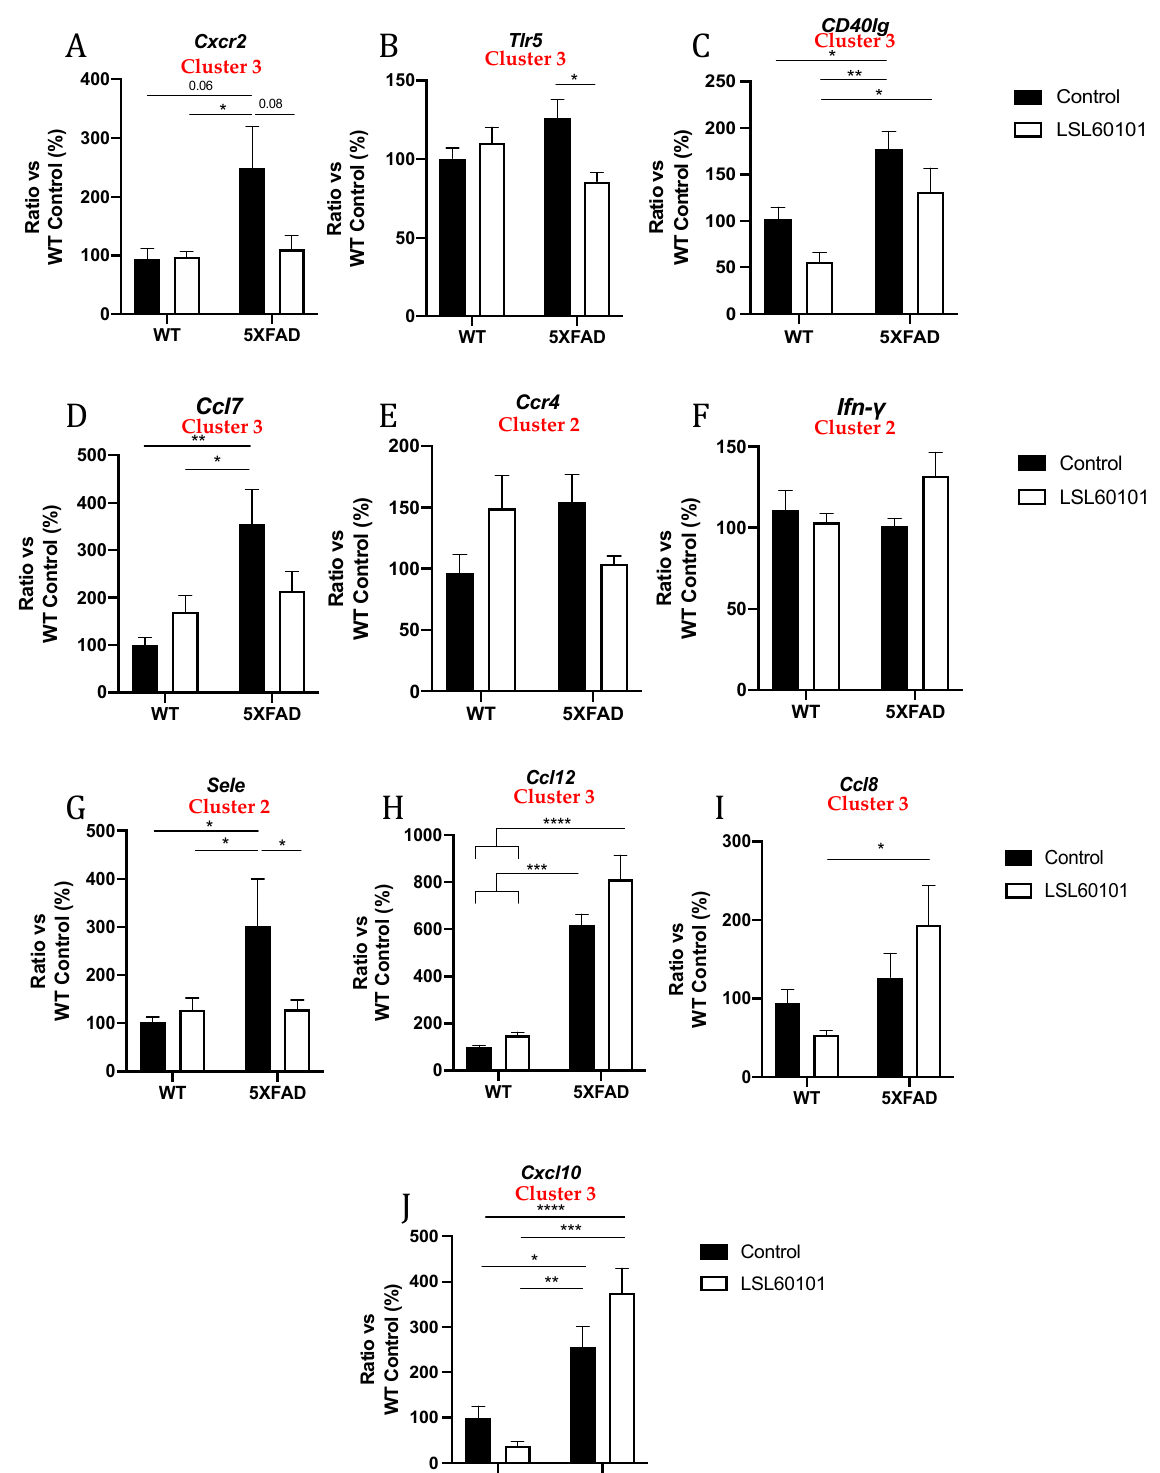
Figure 5. Validation of representative subset of mRNAs. Gene expression of Cxcr2, Tlr5, Cd40lg, Ccl7, Ccr4, Ifn- γ , Sele, Ccl12, Ccl8 and Cxcl10 ( A – J ) in the hippocampus of WT and 5XFAD control and LSL60101-treated mice. Gene expression levels were determined by real-time PCR. Values in bar graphs are adjusted to 100% for relative gene expression of the WT control. Bars represent mean ± SEM. Two-way ANOVA with Tukey post hoc analysis, * p < 0.05; ** p < 0.01; *** p < 0.001; **** p < 0.0001; n = 5–6 per group.